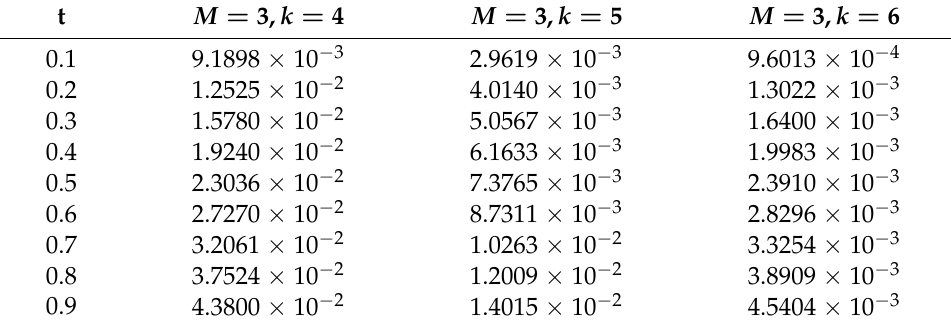
Table 2. Absolute error of y 2 ( t ) for M = 3 and k = 4,5,6 (Example 1).